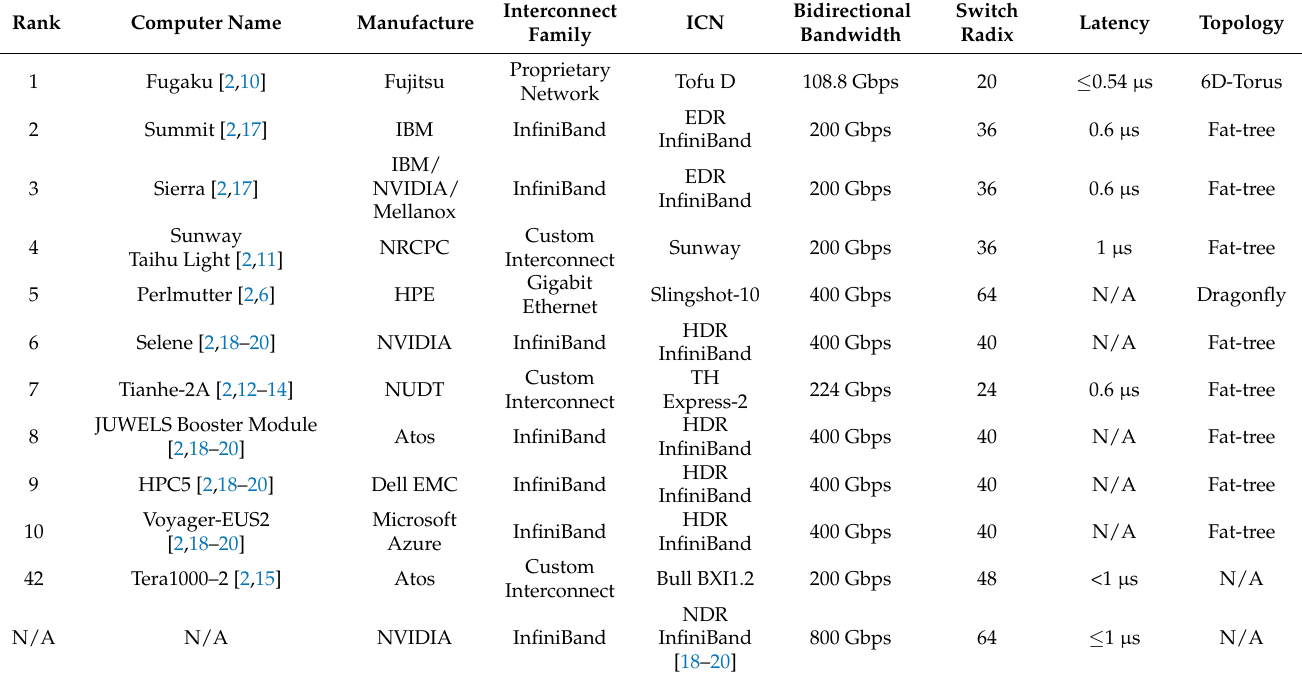
Table 1. Comparison of ICNs of the Top10 HPCs and two additional, representative ICNs with their main